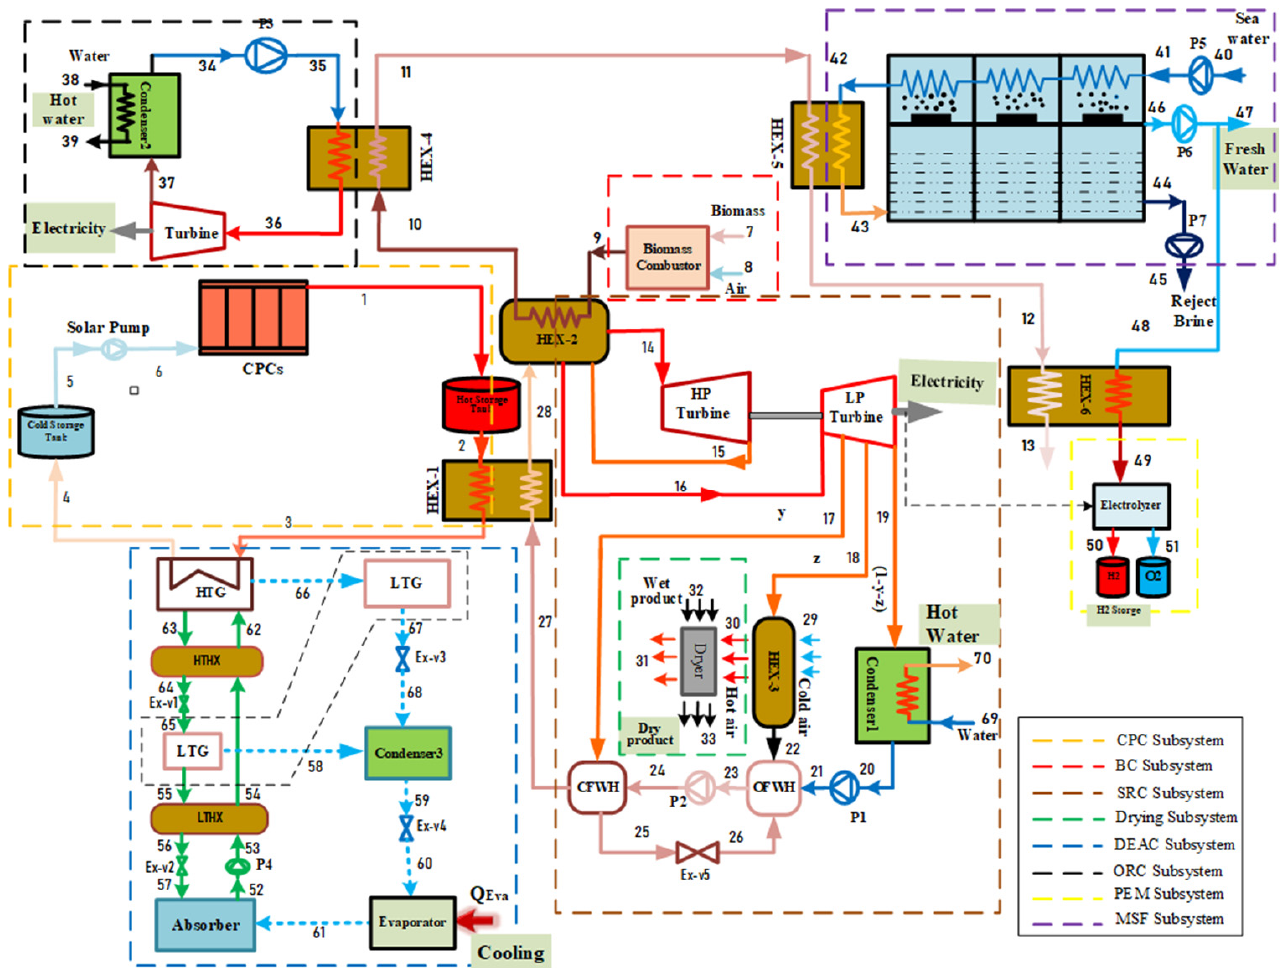
Figure 1. Schematic diagram of the solar and biomass energy integrated cycle for a multi-generation system.